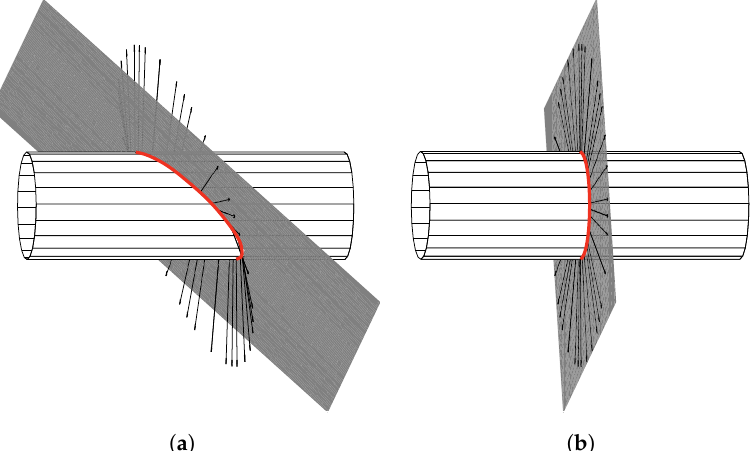
Figure 3. Intersection curve (red) between an exemplarily scanned object (cylinder) and the plane of rotation/translation (scanning plane-gray) of the rod: ( a ) arbitrary arrangement; ( b ) special arrangement resulting in a plane scanning